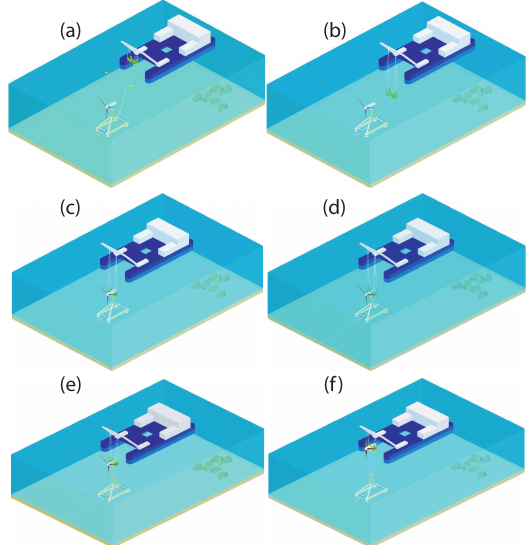
Figure 7. Maintenance operations of the gondola: ( a ) positioning the special vessel above the gondola; ( b ) descent process of the tool; ( c ) coupling process between the tool and the gondola and cable tensioning process; ( d ) activation of the hydraulic system of the tool to fix it to the gondola; ( e ) gondola lifting process; and ( f ) gondola